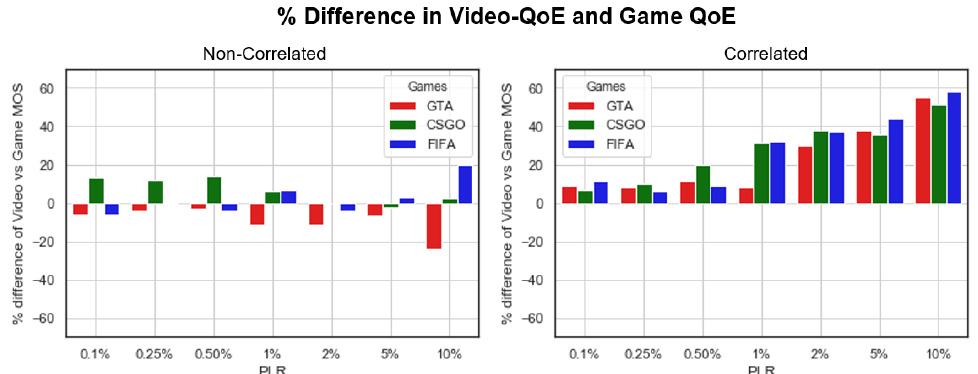
Figure 7. Percentage difference in Video-QoE and Game QoE with and without